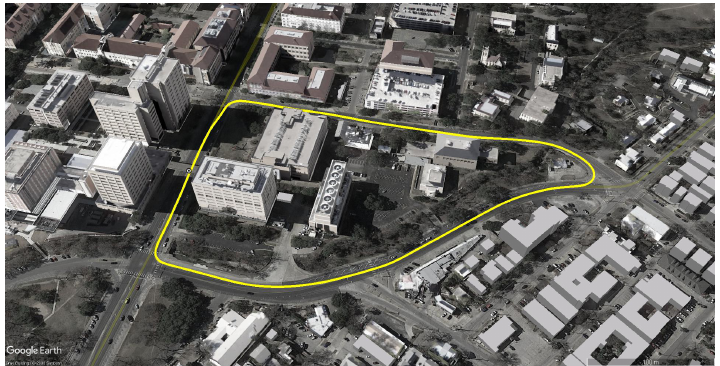
Figure 11. An overview of the 1-km test route. The Dean Keeton corridor, toward the left, is spanned by a pedestrian bridge and flanked by buildings on both sides. A total of 75 laps of the test route were driven over six separate